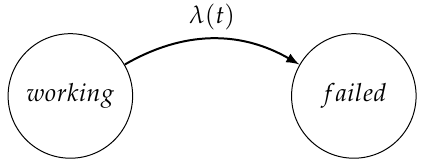
Figure 1. Two state model from the reliability point of view.